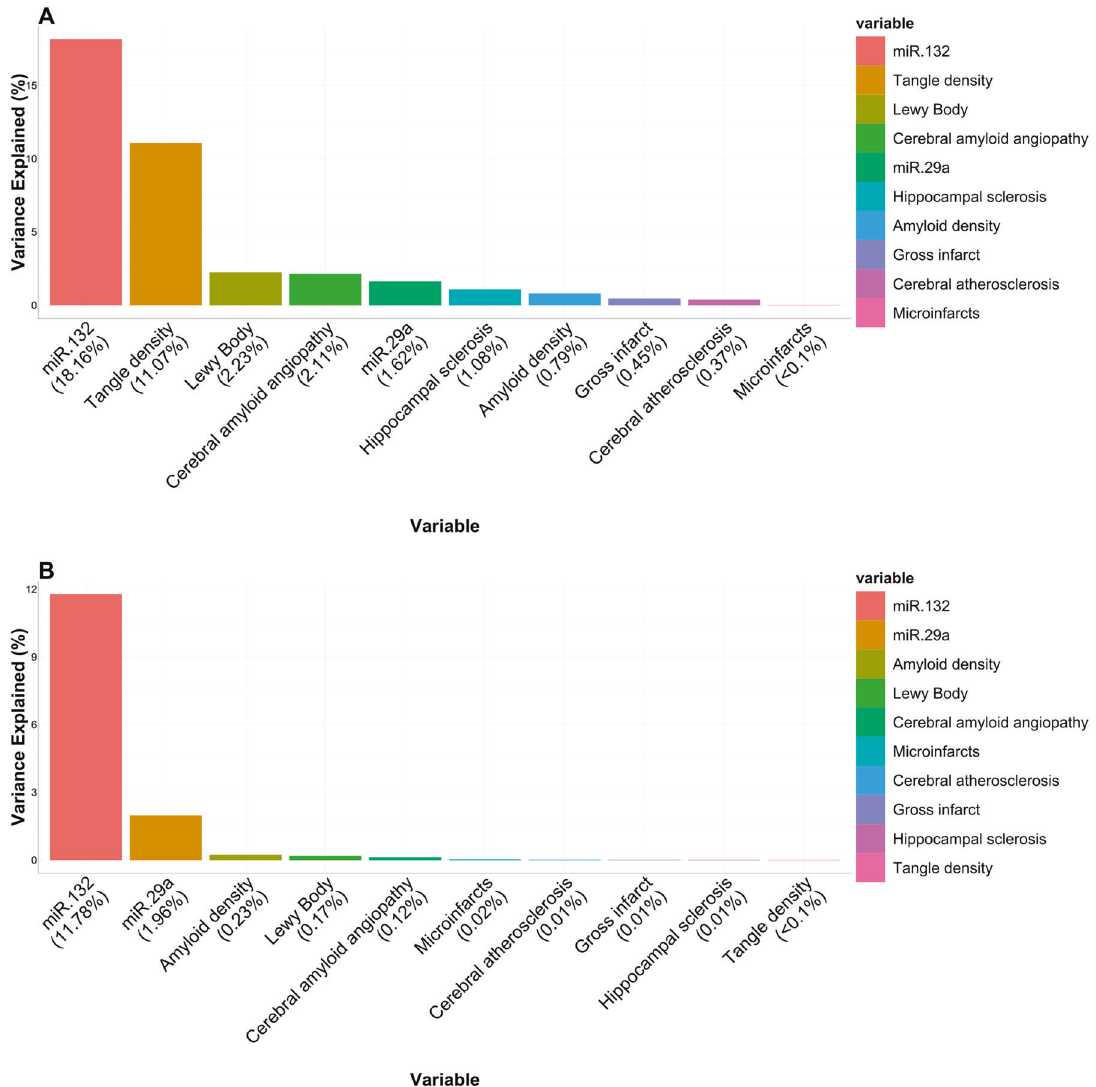
Fig. 3 Percent variance of cognitive trajectory explained by miR-132 and miR-29a. This fi gure shows the percent variance of cognitive trajectory explained by variables in the model. A Percent variance of cognitive trajectory explained by miR-132, miR-29a, and each of the eight considered pathologies (amyloid density, tangle density, Lewy bodies, macroinfarct, microinfarcts, atherosclerosis, cerebral amyloid angiopathy, and hippocampal sclerosis), B Percent variance of cognitive trajectory explained by miR-132 and miR-29a after effects of the eight cerebral pathologies have been regressed out. For all analyses, the effects of sex, age at death, PMI, RIN, study, and proportions of neurons, astrocytes, oligodendrocytes, and microglia have been regressed out in these percent variance estimates. PDHX, HDGF, and DIRAS1. Furthermore, we found 18 transcripts in cognitive trajectory at FDR < 0.05. To determine proteins and 2 proteins that are common targets of both miR-132 and miR- differentially expressed in cognitive trajectory, we used the fi ndings from our meta-analysis of two proteome-wide association 29a in cognitive trajectory (Supplementary Table 13). In our prior work, we derived protein co-expression modules studies of cognitive trajectory in Banner and BLSA cohort, respectively (Supplementary Table 10) [28]. These datasets are independent of the ROS/MAP studies and yielded 229 proteins with decreased abundance and 350 proteins with increased abundance in cognitive trajectory at FDR p < 0.05 [28] (Supple- mentary Table 11). Using the above-described criteria, we found 22 putative targets of miR-132-3p and 41 putative targets of miR- 29a-3p in cognitive trajectory at the protein level (Supplementary Table 12). The overlap between the targets of miR-132-3p at the transcript level (identi fi ed in ROS/MAP cohorts) and at the protein level (identi fi ed in Banner and BLSA cohorts) were MECP2 and RPH3A. The overlap between the targets of miR-29a-3p in cognitive trajectory at the transcript and protein level included SLC30A3,